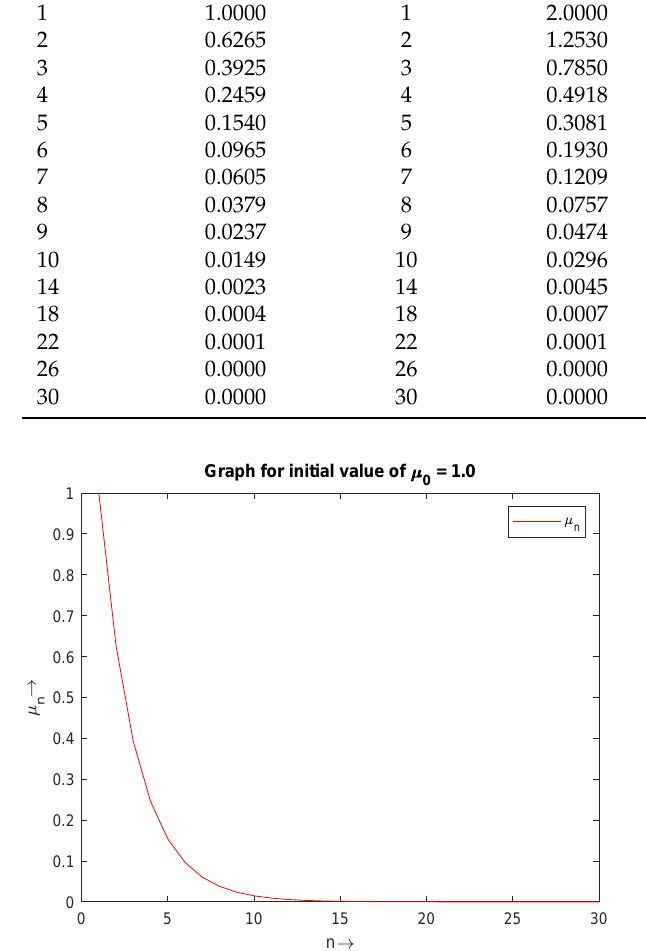
Figure 1. The convergence of { µ n } with initial value µ 0 = 1.